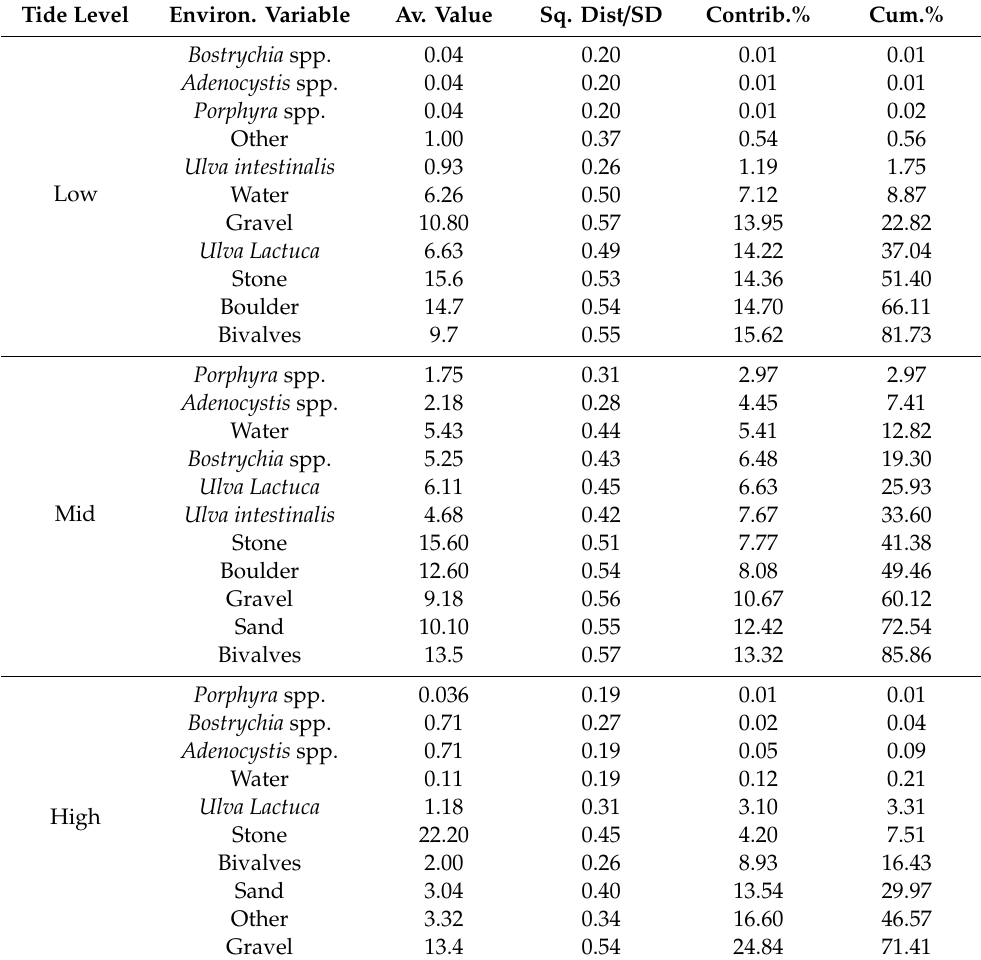
Table 2. Similarity Percentages (SIMPER) analysis of the environmental variables that contributed 90% of the habitat composition within the three tidal zones studied in R ó balo Bay, Navarino Island, Chile (Contrib.% = percentage of variable contribution; Cum.% = cumulative